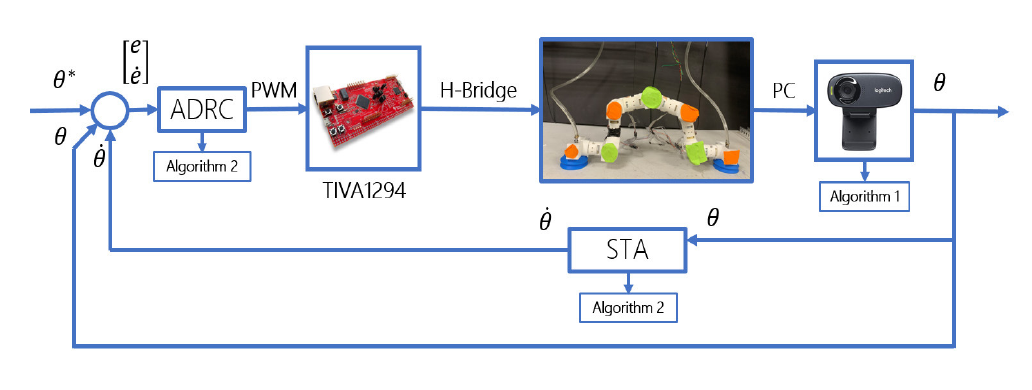
Figure 6. Implementation control in the